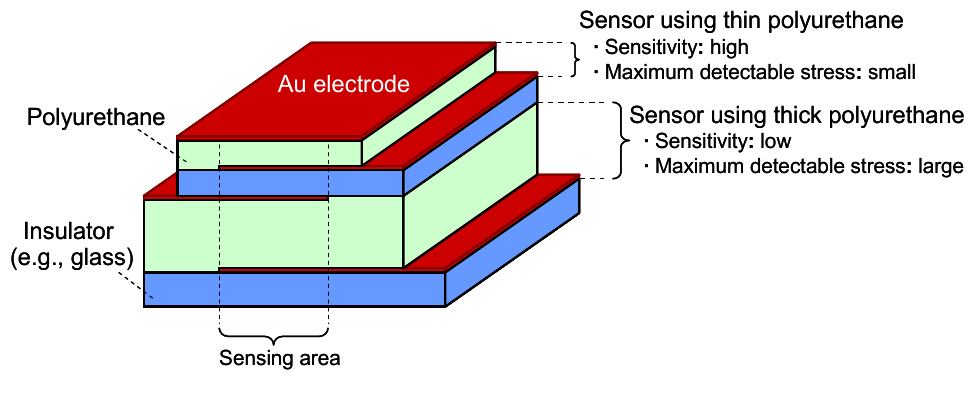
Figure 13. Schematic of stacked sensor for increasing measurable pressure range while keeping